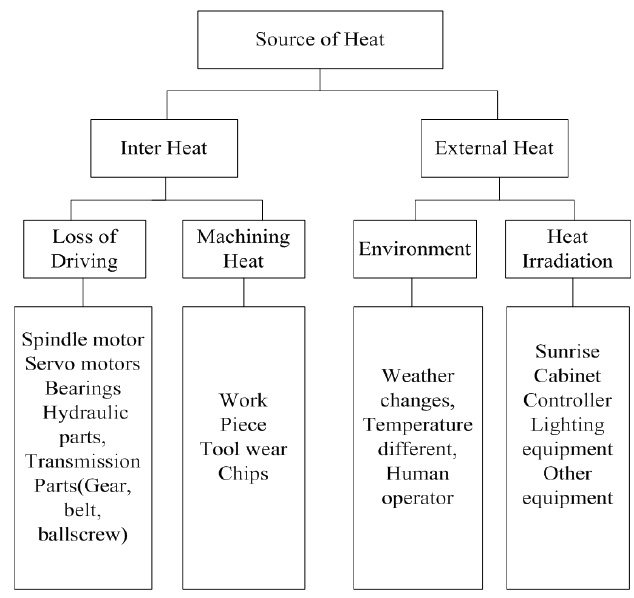
Figure 2. Factors inducing thermal deformations.